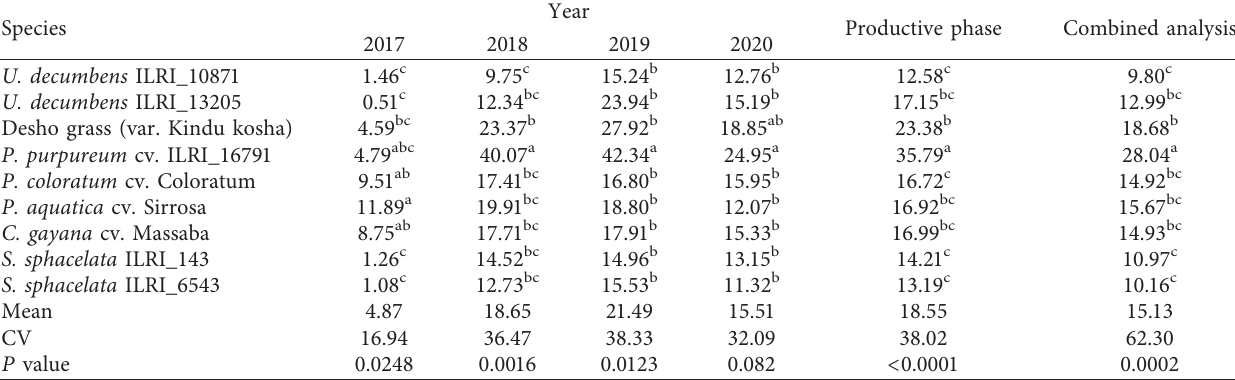
Table 5: Forage dry matter yield (t/ha) of perennial forage grass species evaluated under irrigation supplementation.